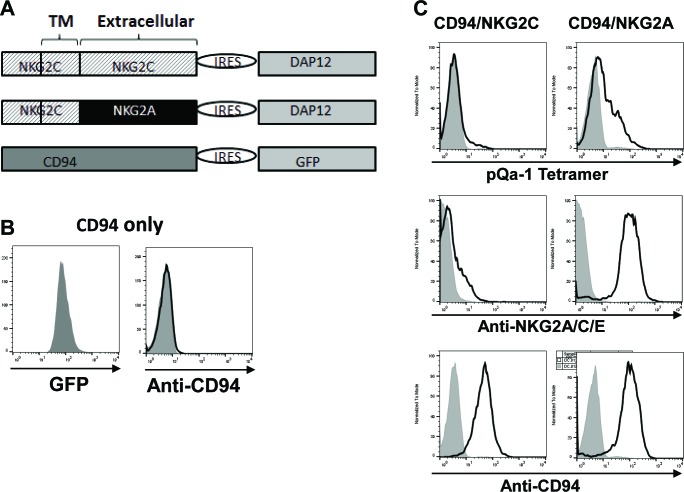
pQa-1-dtSCT tetramer stains CD94/NKG2A expressing cells stronger than CD94/NKG2C-expressing cells.(A) Schematic depiction of the constructs for expression of CD94, CD94/NKG2C or CD94/NKG2A. (B) Mouse T lymphoma cell line BWZ.36 expressing CD94 alone indicated by GFP could not be detected by surface anti-CD94 staining. (C) BWZ.36-CD94 cells in (B) co-expressing NKG2C and DAP12 or NKG2A and DAP12 were stained by pQa-1-dtSCT tetramer, anti-NKG2A/C/E or anti-CD94, respectively. Parental BWZ.36 cells served as background (shaded peak). The data shown in (B) and (C) had been observed repeatedly.